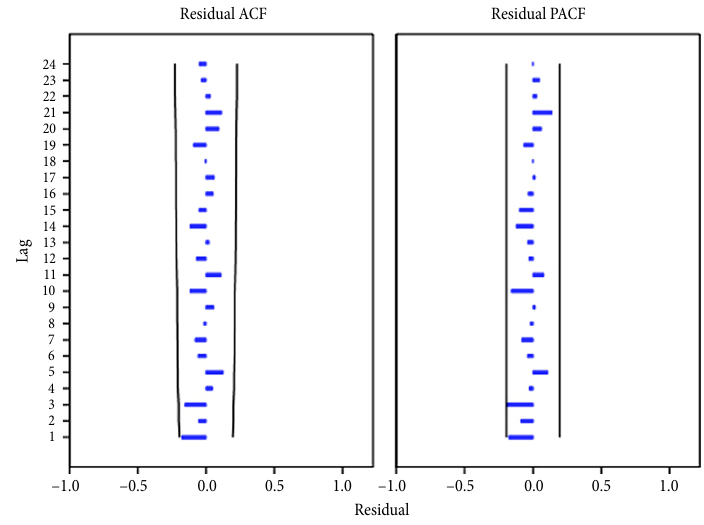
Figure 5. ACF and PACF of residuals Table 2. Forecasts of railway passenger flows in thousands (July 2013 – June 2014): observed passenger counts ( x l ), forecasted pas- senger counts ( ˆ l x ), monthly forecast errors ( e l ) and monthly absolute percent error (APE l ) are displayed for Seasonal Exponential Smoothing (SES) model and SARIMA (SAR)